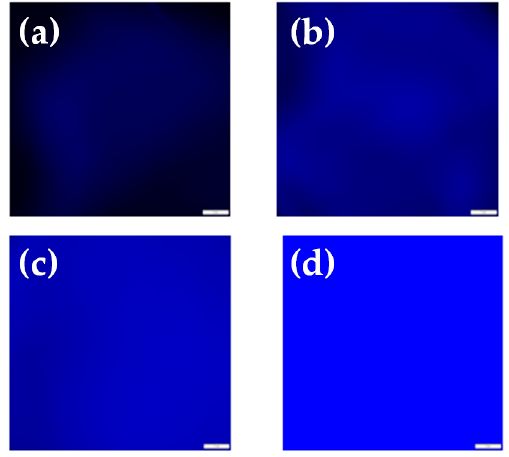
Figure 7. Fluorescence images analyzed using the CellSens software. Images ( a , b ) correspond to the Cu 2+ -loaded system equilibrated in 5 × 10 − 3 M Cu 2+ methanol solution prior to and after immersion in the ethylenediaminetetraacetic acid (EDTA) aqueous solution, respectively. Images ( c , d ) correspond to the Cu 2+ -loaded system equilibrated in 10 − 3 M Cu 2+ methanol solution prior to and after immersion